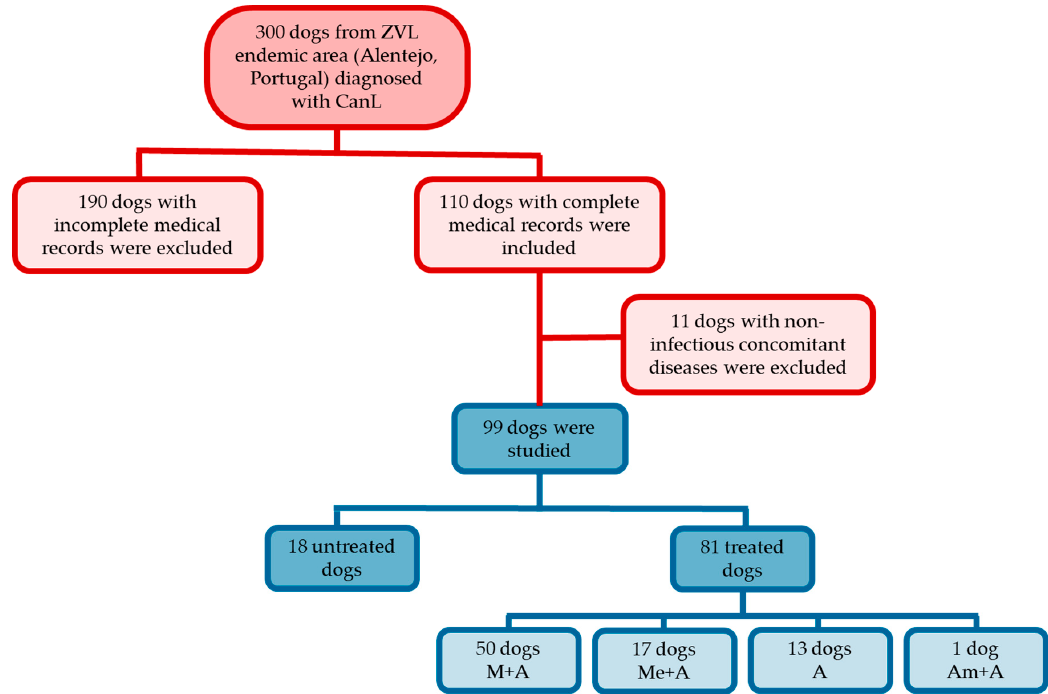
Figure 1. Flowchart representing the case selection process used in the current study. From 300 dogs living in an endemic area of zoonotic visceral leishmaniosis (ZVL) diagnosed with canine leishmaniosis (CanL), 99 dogs were selected and evaluated. Dogs were treated with miltefosine in combination with allopurinol (M + A), meglumine antimoniate in association with allopurinol (Me + A), allopurinol in monotherapy (A) or aminosidine in combination with allopurinol (Am + A).